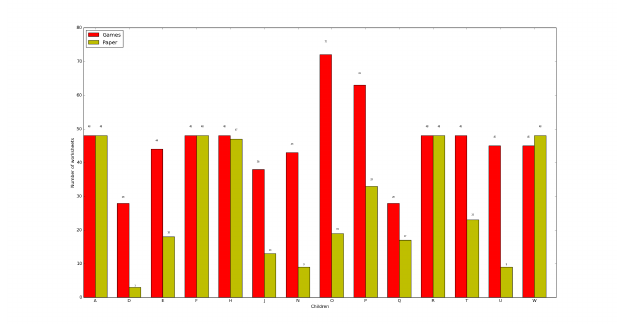
Figure 13. Variations in the number of unique worksheets handled by the different children according to the two contexts (paper and digital games). Due to errors in activity records and absences that may distort the results, the student group is reduced here to only 14